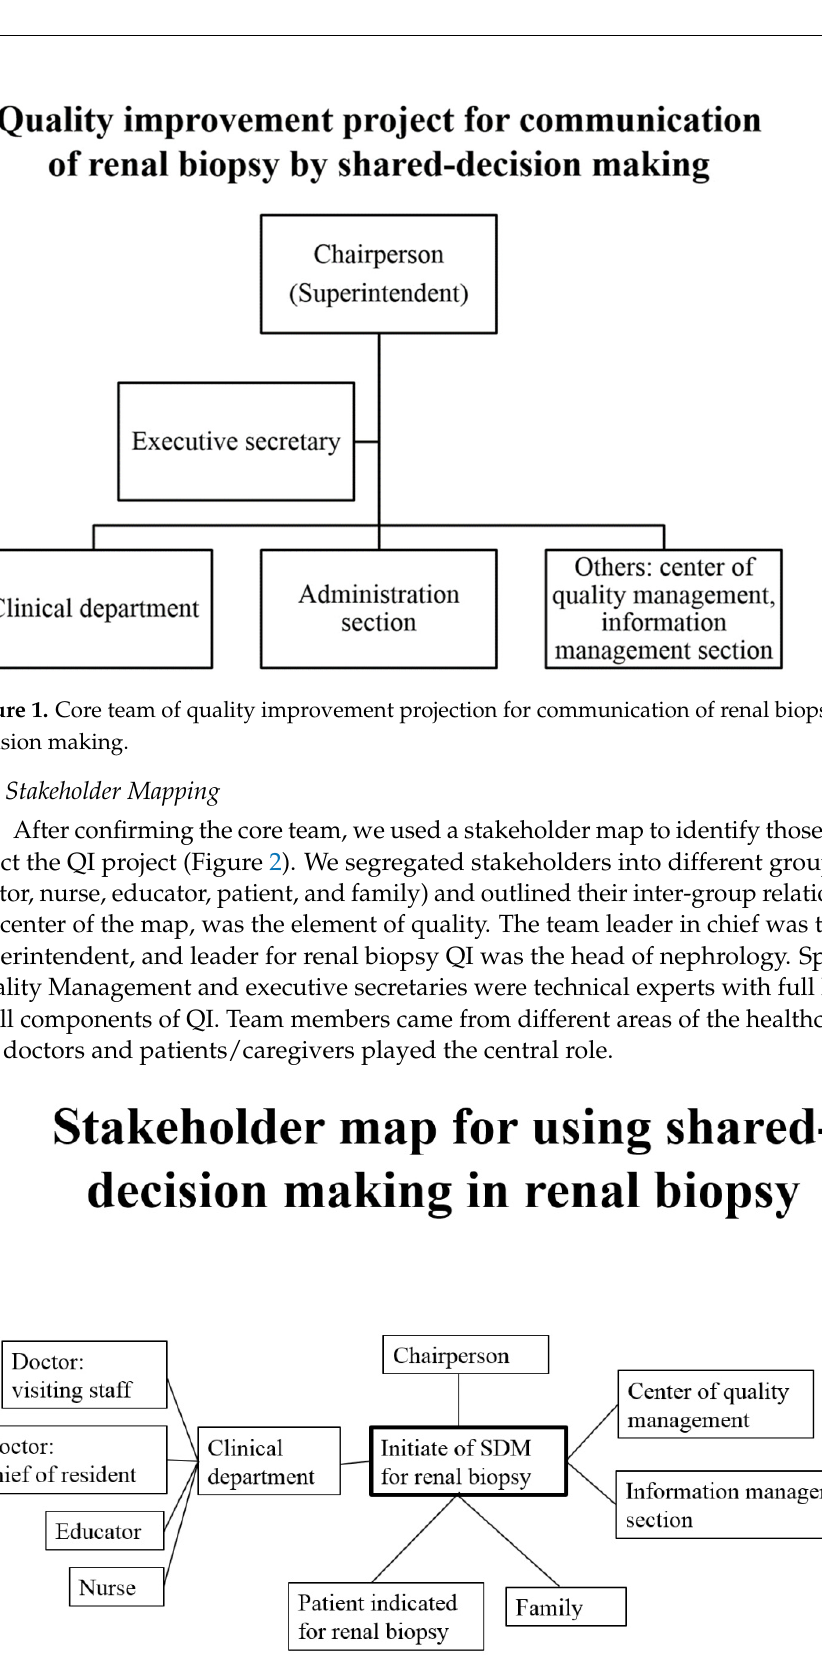
Figure 2. Stakeholder map for using shared decision making in renal biopsy.